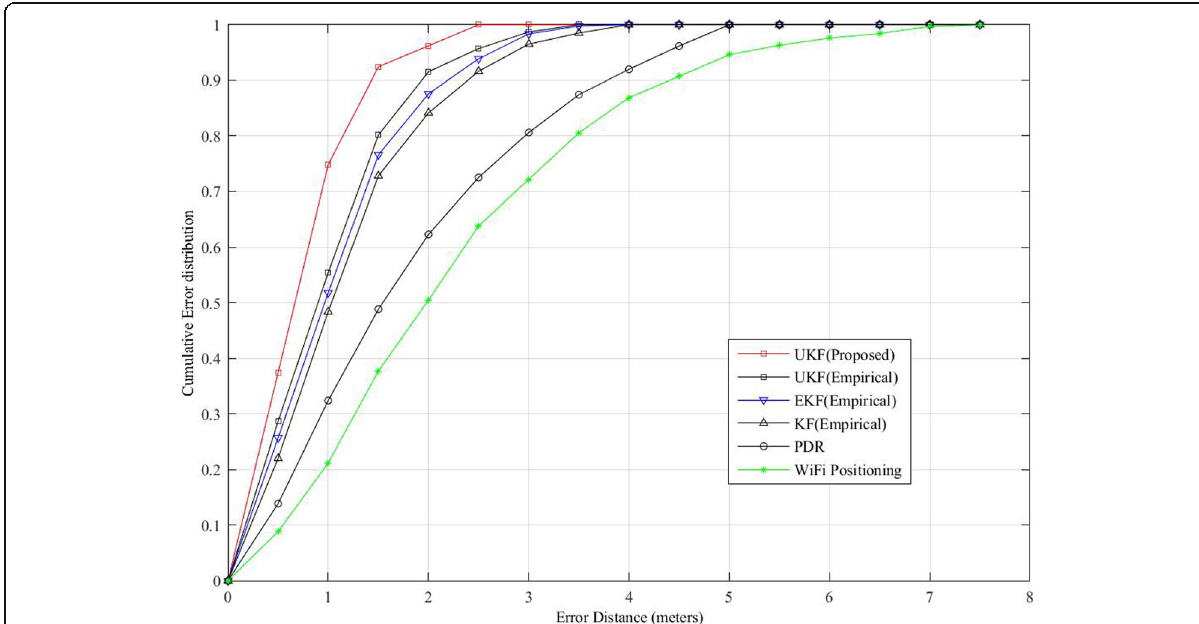
Fig. 5 Localization accuracy comparisons. The compared approaches include the proposed UKF-based integrated approach, UKF (empirical), EKF (empirical), KF (empirical), PDR, and WiFi positioning